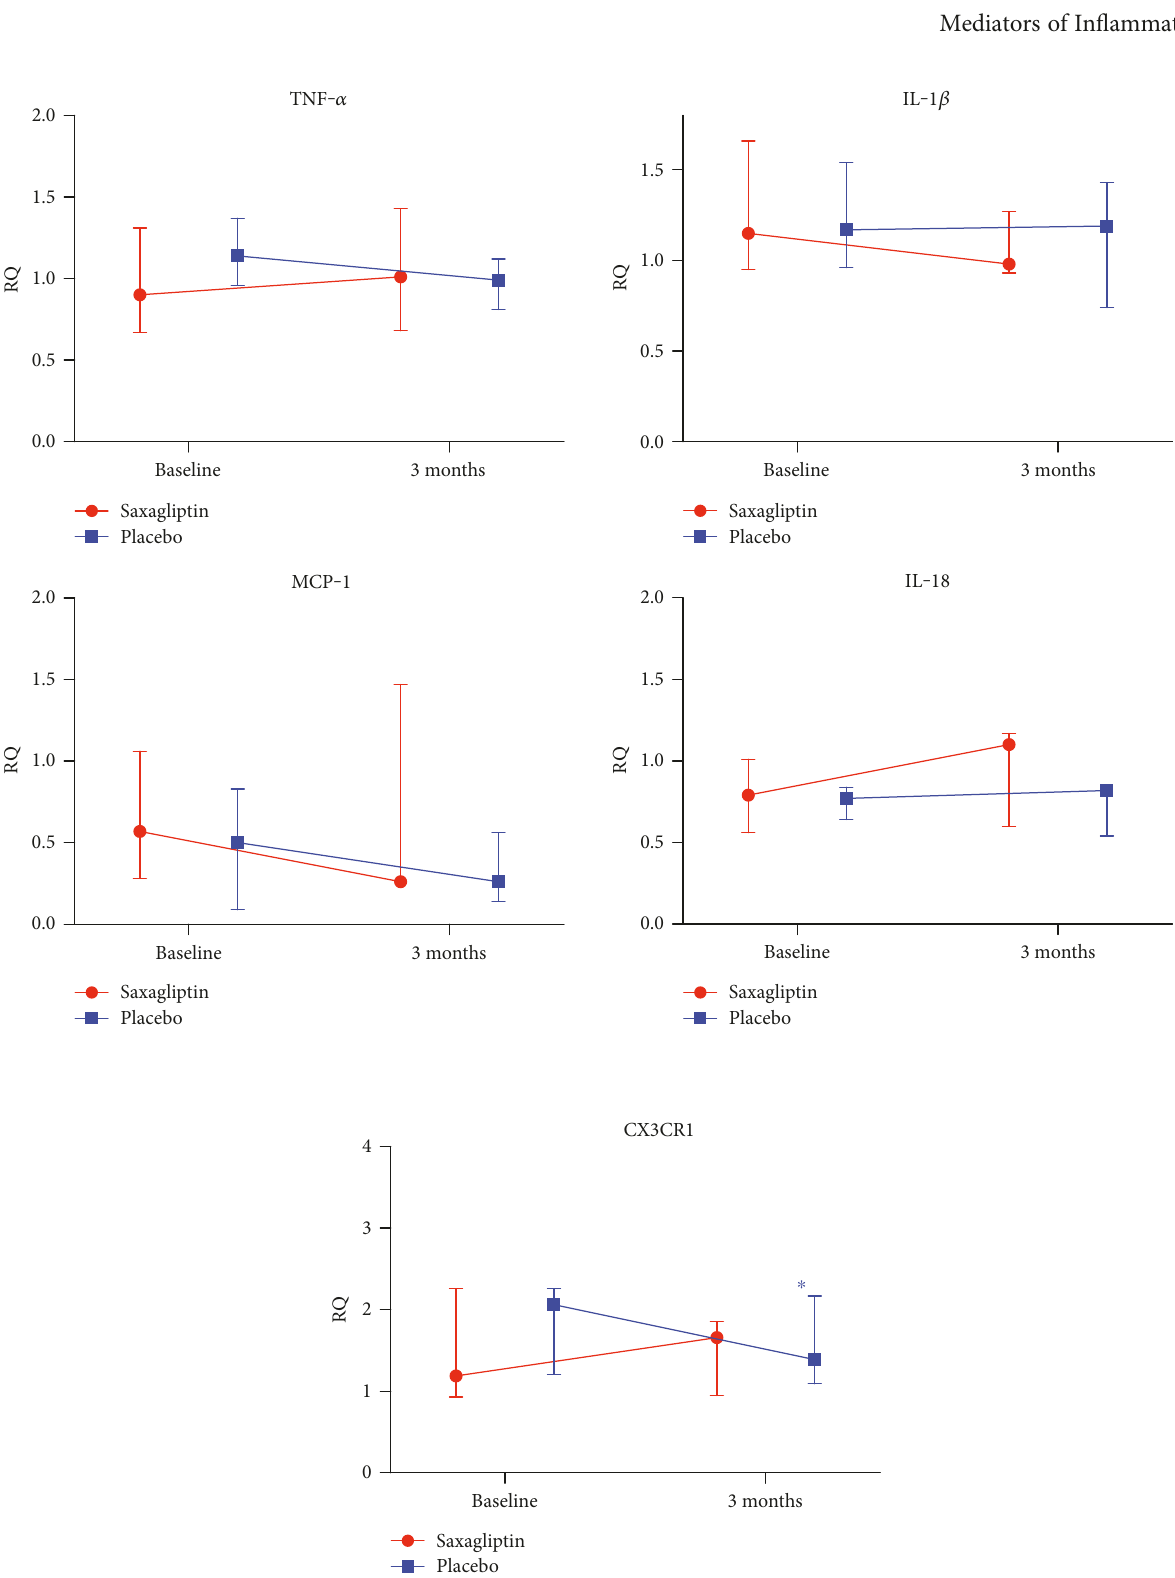
Figure 2: mRNA RQ values in circulating leukocytes before (baseline) and after treatment (3 months). Median values are given, with 25 and 75 percentiles depicting the spread. ∗ Intragroup change, p = 0 043 . There were no statistically signi fi cant di ff erences in relative changes of the selected proin fl ammatory markers between the